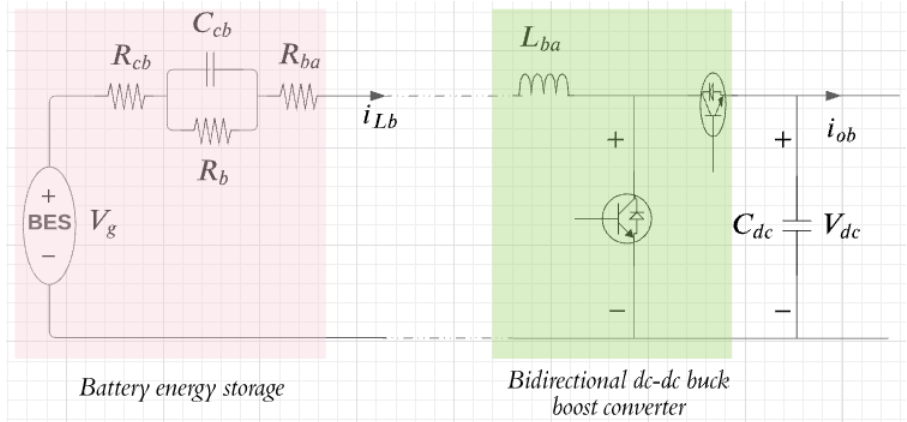
Figure 3. Circuit diagram of DC-bus connected battery energy storage through bidirectional DC-DC buck-boost